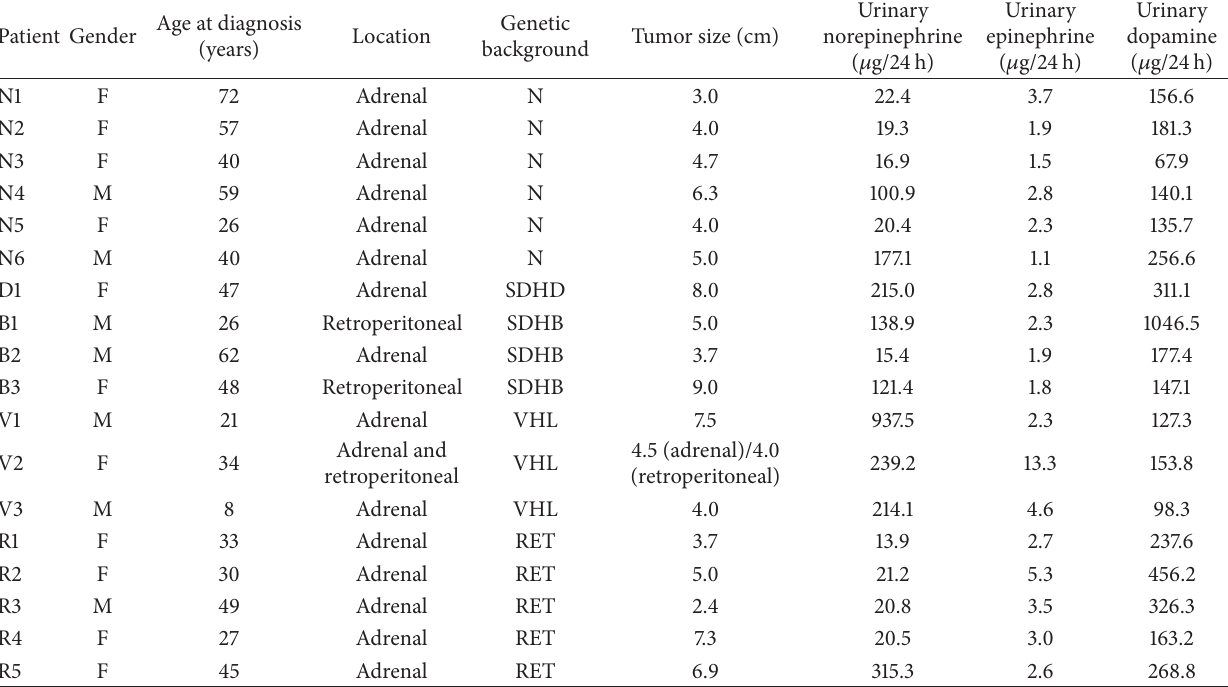
Table 1: Patients’